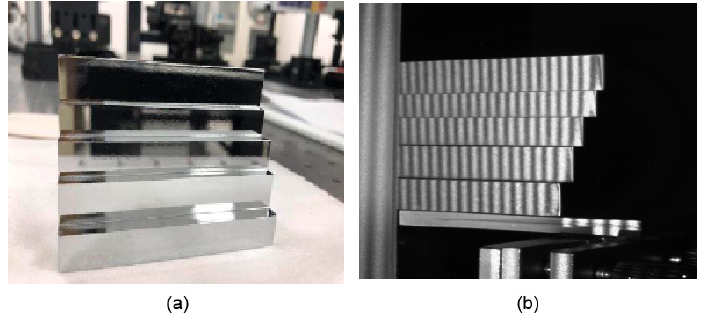
Figure 6. Captured patterns of an artificial mirror step. ( a ) Photo of the mirror step; ( b ) Captured infrared patterns reflected by the mirror step. Table 2. Experimental results of the mirror step (units: